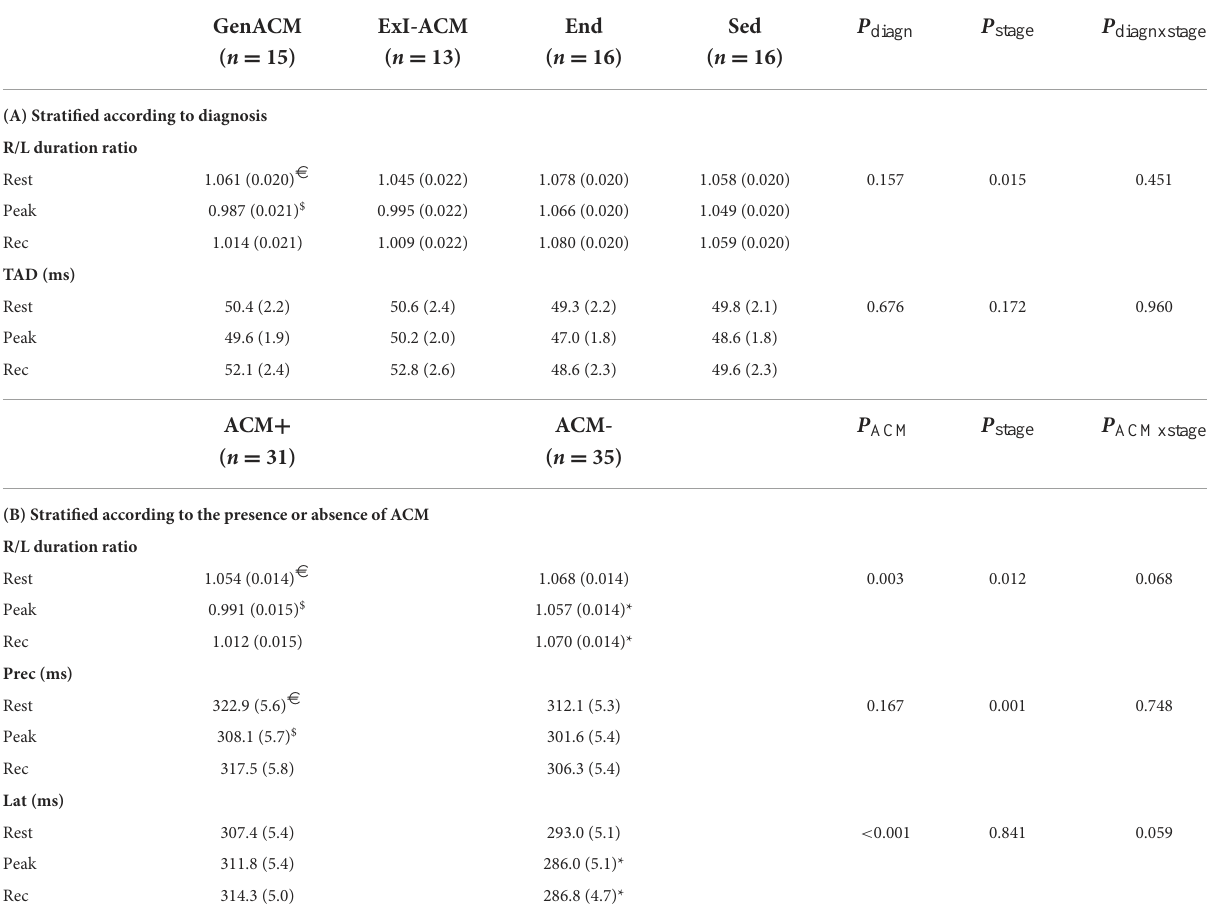
TABLE 3 Depolarization